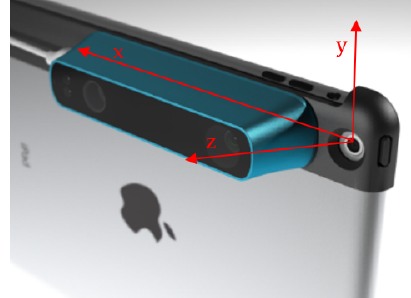
Figure 2. Structure sensor coordinate